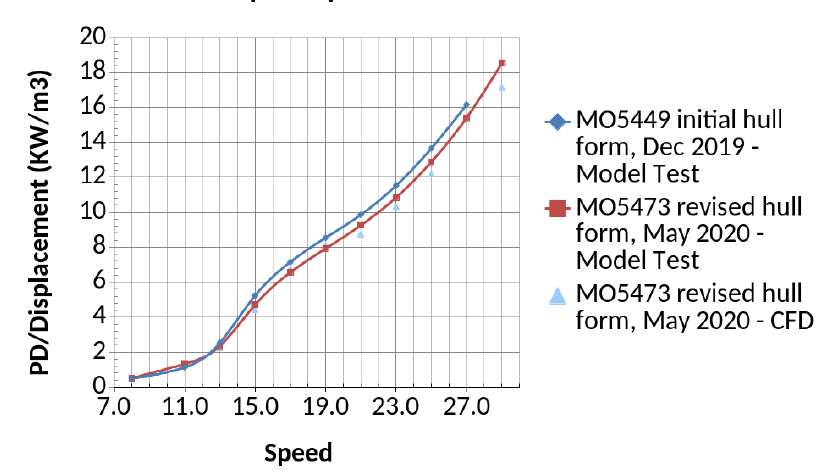
Figure 7. Prediction of rated delivered horsepower under trial conditions for the Stavanger demonstrator on the basis of model experiments and CFD calculations by HSVA (originally optimized tested in December 2019 and revised hull form tested in May 2020).